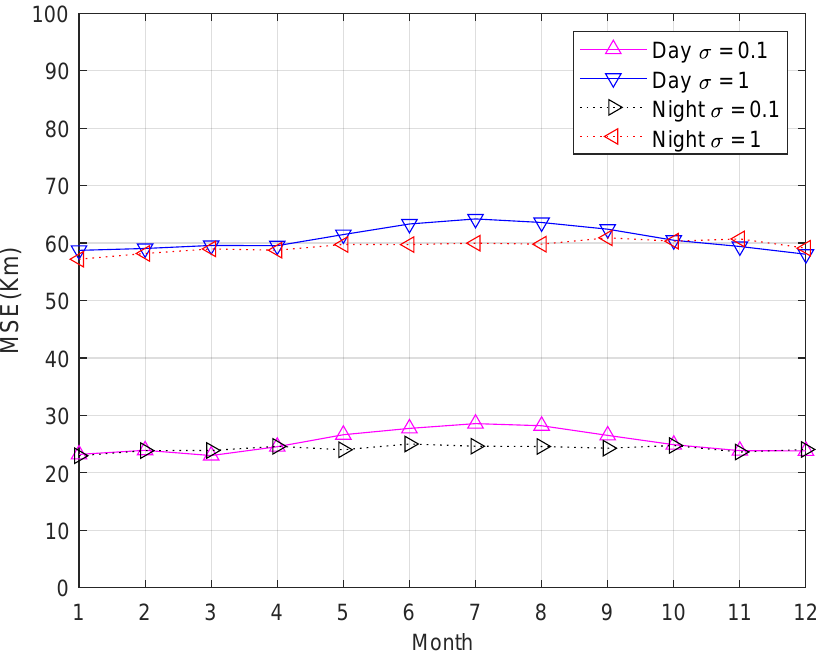
Figure 5. MSE of HF source position estimation in the daytime and nighttime in different